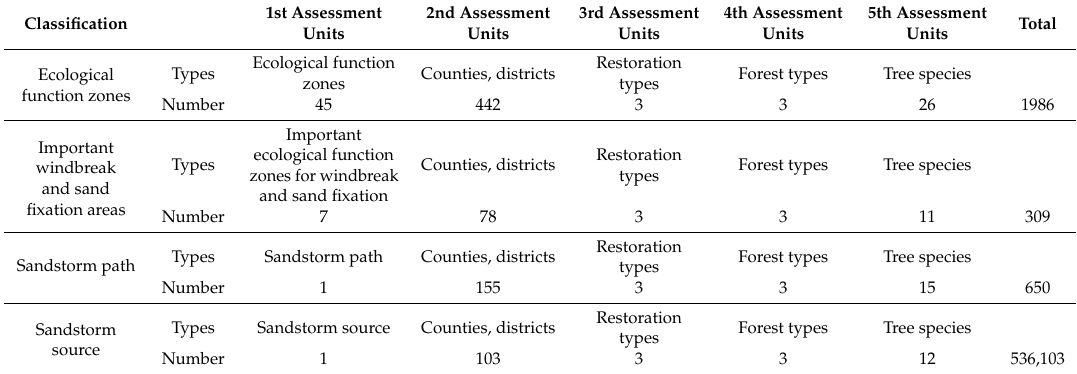
Table 3. Distribution of assessment units by assessment